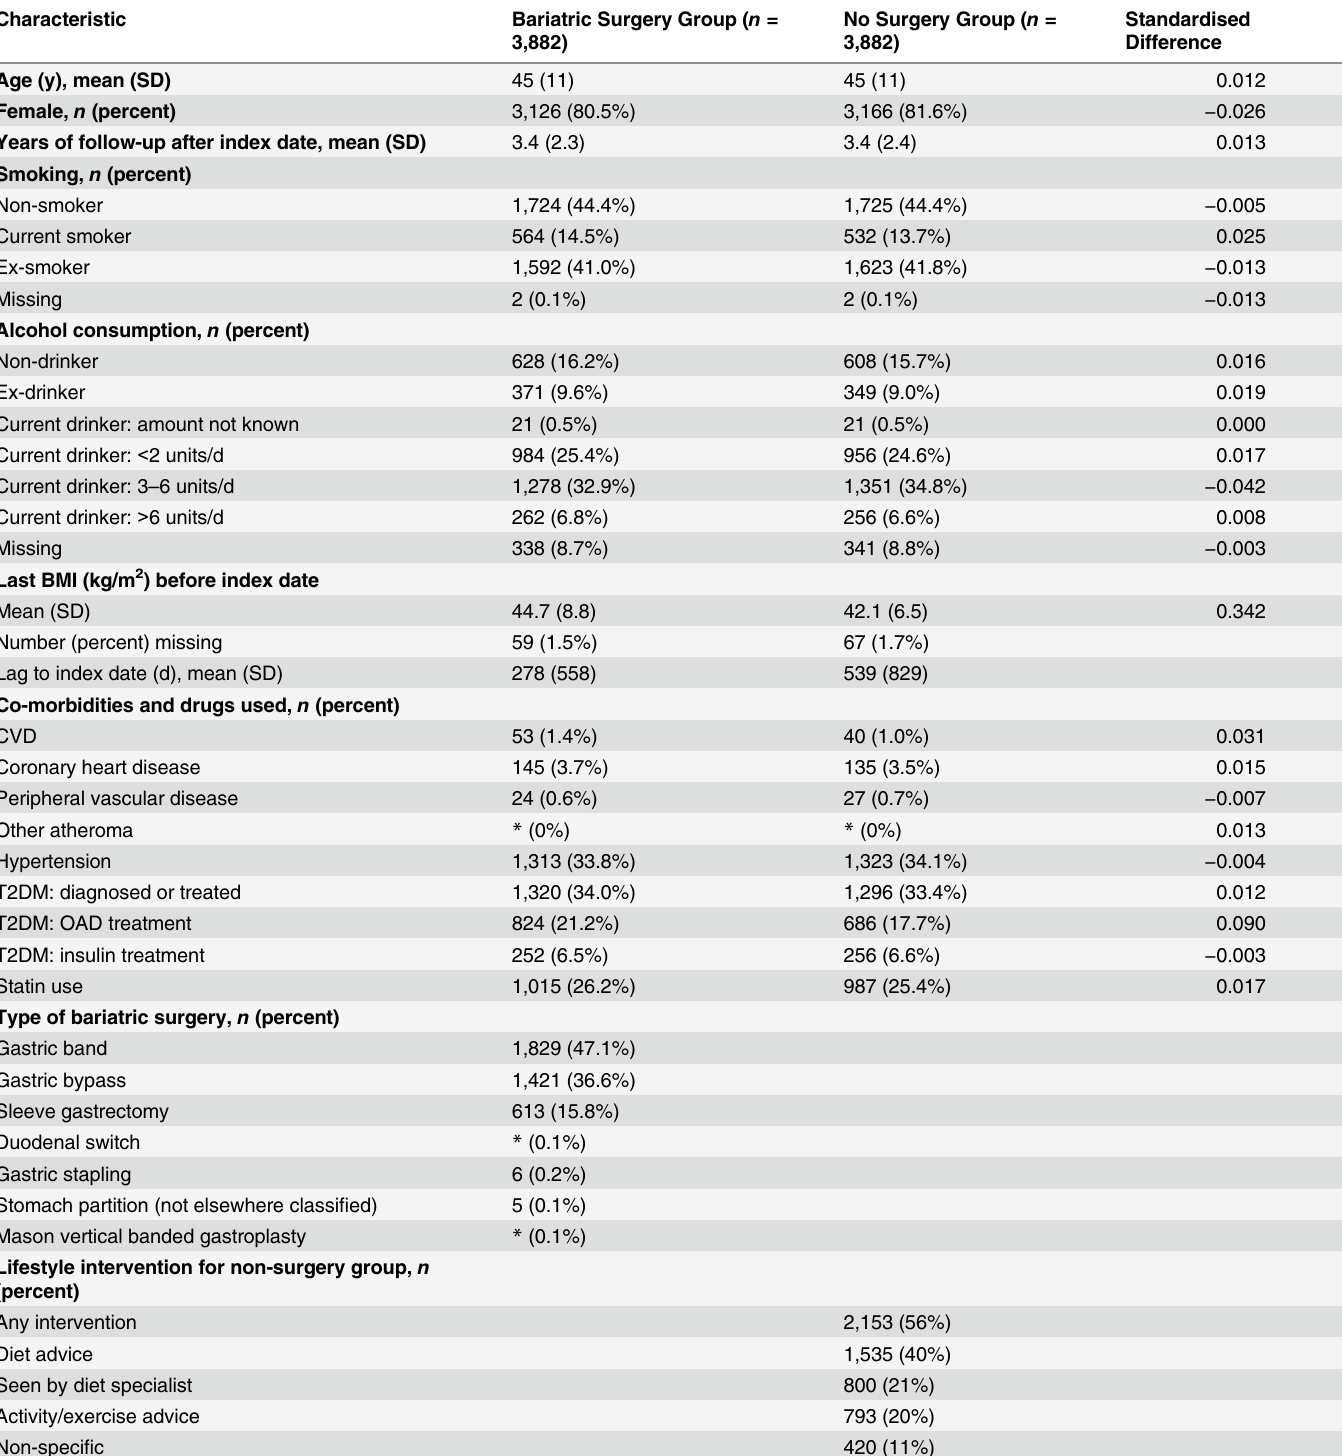
Table 1. Background characteristics of propensity-score-matched cohort of patients with and without bariatric surgery.